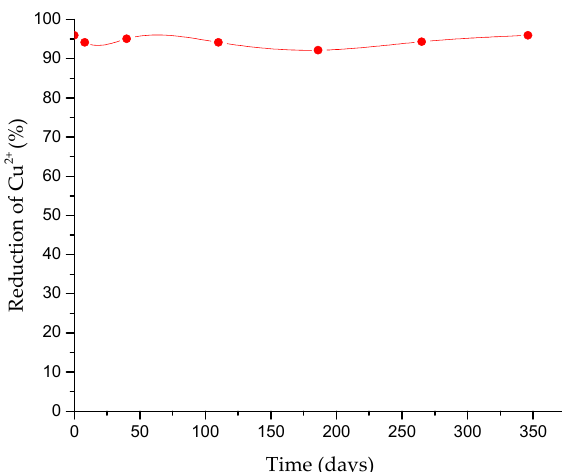
Figure 4. The variation in copper reduction by the functionalized MPS36 over time at 10 bar pressure, 200 RPM and ambient temperature.